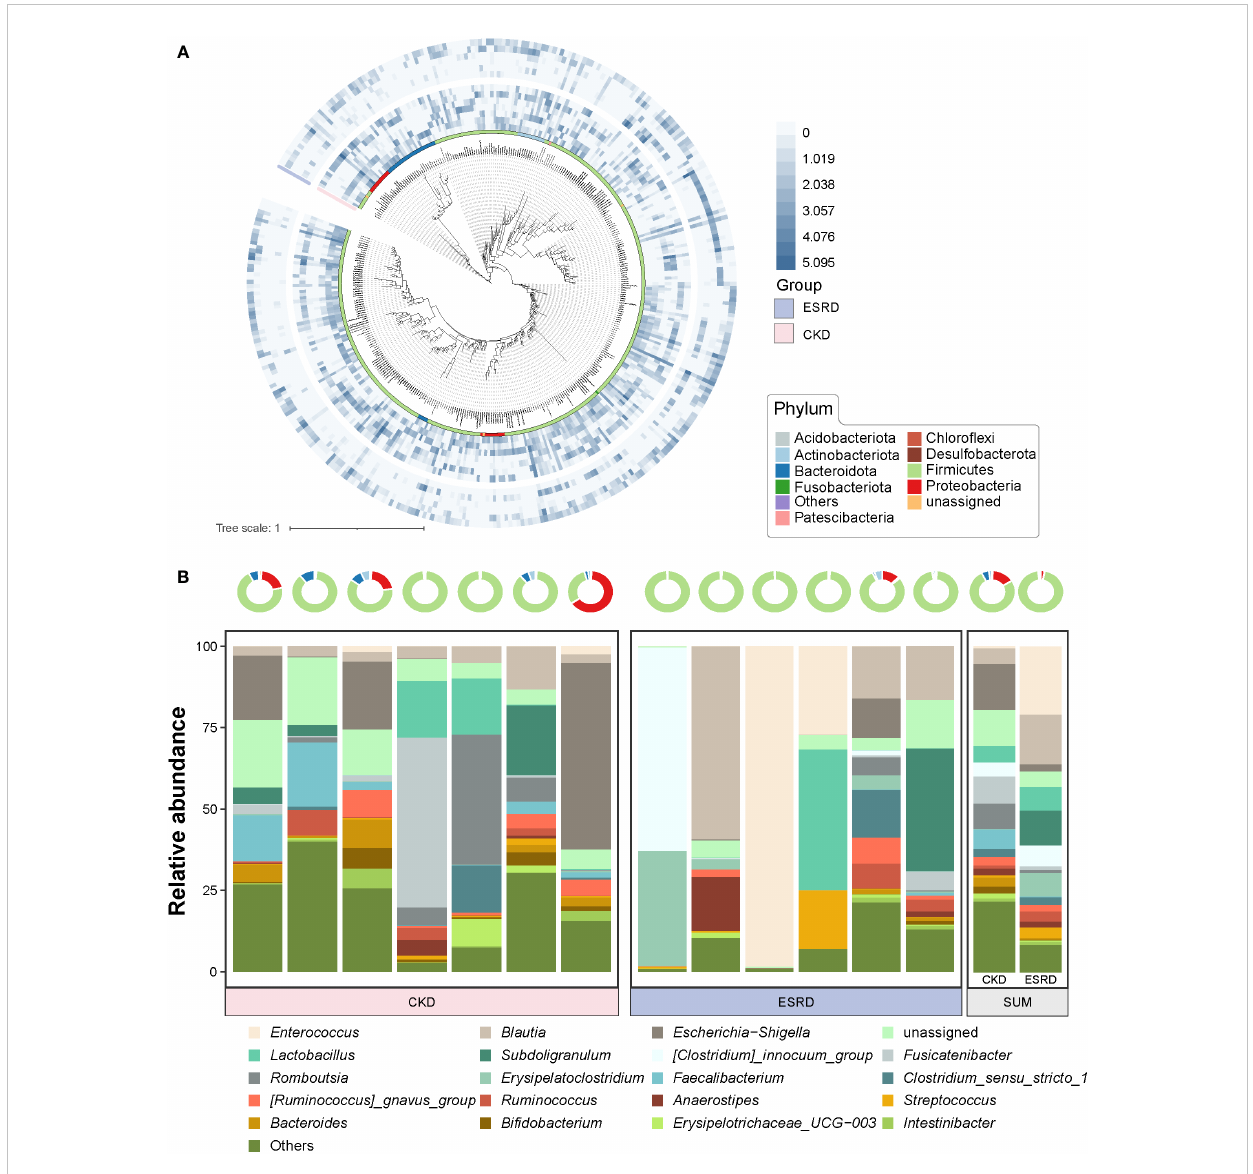
FIGURE 2 Evolutionary relationships and composition of gut microbiota in the CKD and ESRD groups (A) Circular maximum likelihood phylogenetic tree of high relative abundance of OTUs (> 0.02%). The inner band shows OTUs colored by phylum. The out heatmap present the relative abundance of OTUs in each sample. (B) Ring plot represented the relative abundance in top 10 phylum of all samples. Stacked bar plot represents the relative abundance of top 20 genera in all